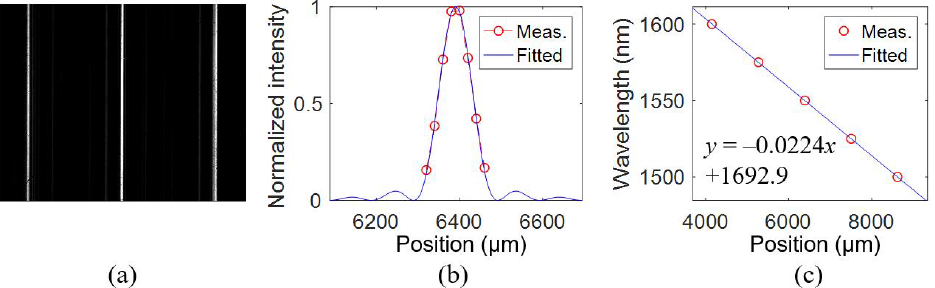
Figure 14. Measured results of WSL4. ( a ) Spectral lines at 1550 nm. ( b ) Measured and fitted far-field distributions with an FWHM of 2.0 nm at 1550 nm. ( c ) Measured and fitted wavelengths at different pixel positions.